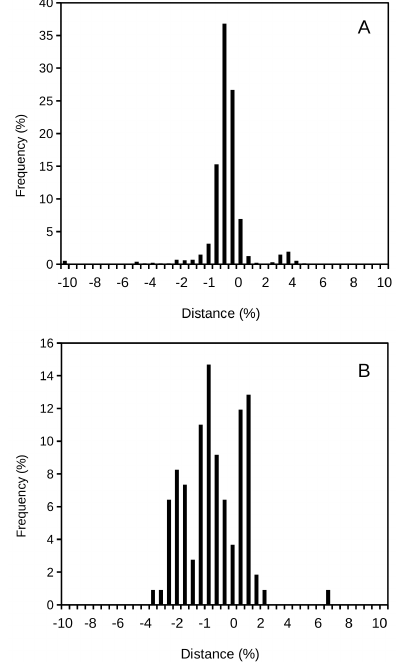
Figure 3. Examples of uni-modal and multi-modal distributions shown with the examples of Shigella sonnei ( A ) and Shigella boydii ( B ), respectively, when plotting distance among strains versus their frequency distribution. Note the multiple peaks observed within the spectrum of the species S. boydii while S. sonnei shows a single peak. Distance represents the percentage of dissimilarity against the reference